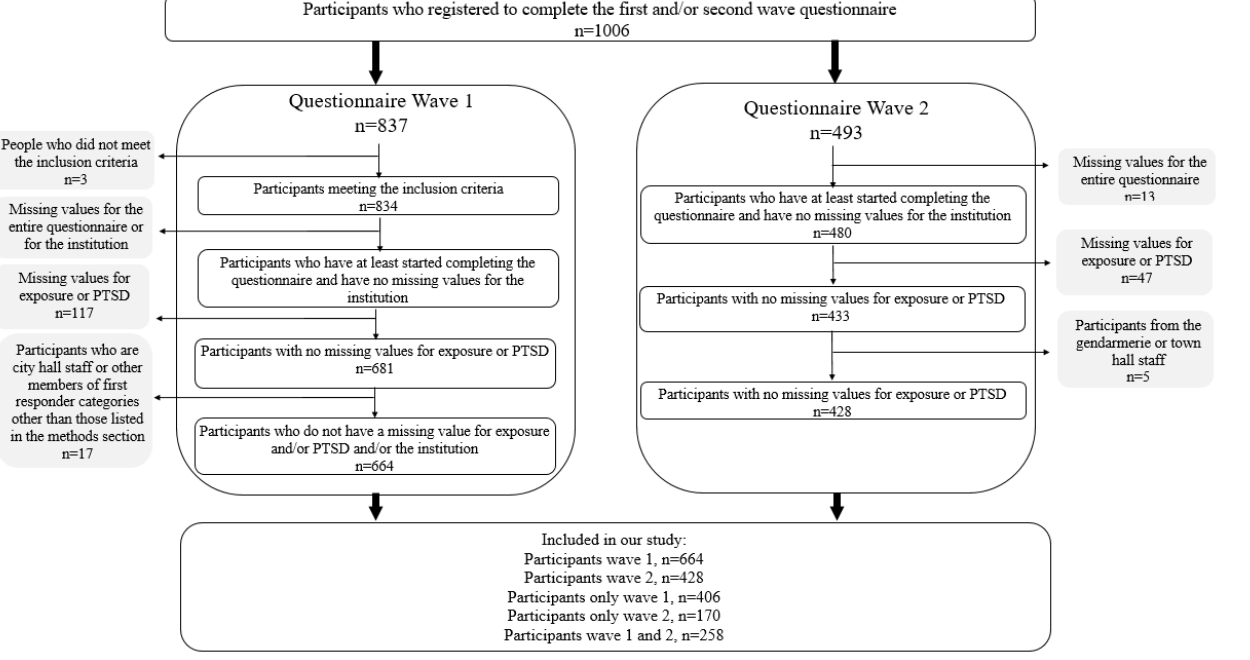
sionals, 17.1% were affiliated volunteers and 13.8% were police officers. Women repre- sented 28.7% of the sample and men 71.3%. More specifically, women represented 61.1%, 32.9, 32.2, and 3.3% among health professionals, affiliated volunteers, police forces, and firefighters, respectively. The average age was 41.1 years (standard deviation=10.2 years; 10 missing values) from 36.5 years old among firefighters to 48.6 years old among health professionals. Sociodemographic characteristics, exposure, mental health history, previ- ous traumatic or difficult events, training, social isolation, and COVID-19 concern by FR category are described in Table S1. Of the 258 participants in both waves, 37.6% were fire- fighters, 26.4% were health professionals, 19% were affiliated volunteers, and 17.1% were police officers. Women represented 32.6% of the sample and men 67.4%. The average age was 37.9 years (standard deviation = 10.2 years). 3.2. Factors Associated to Attrition In multivariate analysis, attrition was higher among health professionals compared with firefighters (OR= 1.88; 95% CI [1.08 – 3.26]). It was lower among participants with PTSD compared with those without PTSD (OR= 0.41; 95% CI [0.19 – 0.88]) and among those reporting low daily social support (OR = 0.53; 95% CI [0.3 – 0.93]) (Table S2). 3.3. Prevalence of PTSD and Partial PTSD Five Years after the Attacks The overall prevalence of PTSD 5 years after the attacks in our study sample of FR who participated in the second phase of the ESPA 13 November survey (n = 428) was 8.6%, ranging from 5.5% among affiliated volunteers to 11.9% among police officers. That of partial PTSD was, in total, 22%, ranging from 14.8% among health professionals to 33.9% among police officers (Table 1).